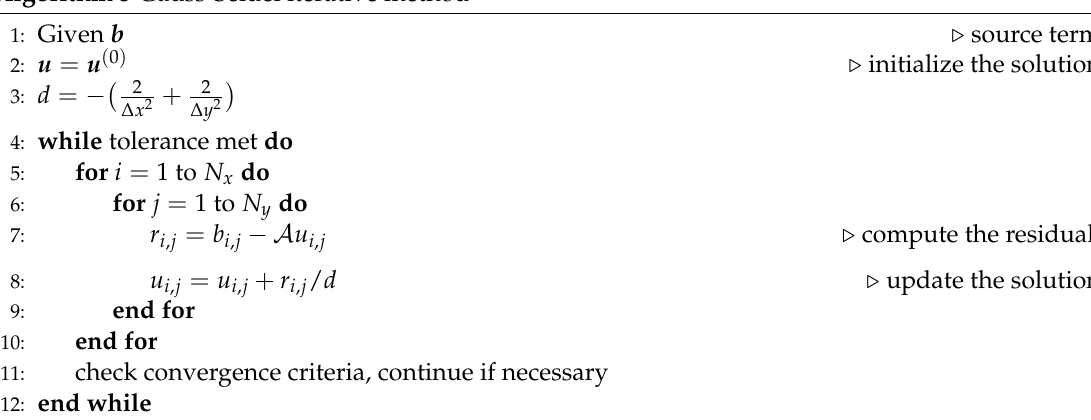
Algorithm 3 Gauss-Seidel iterative